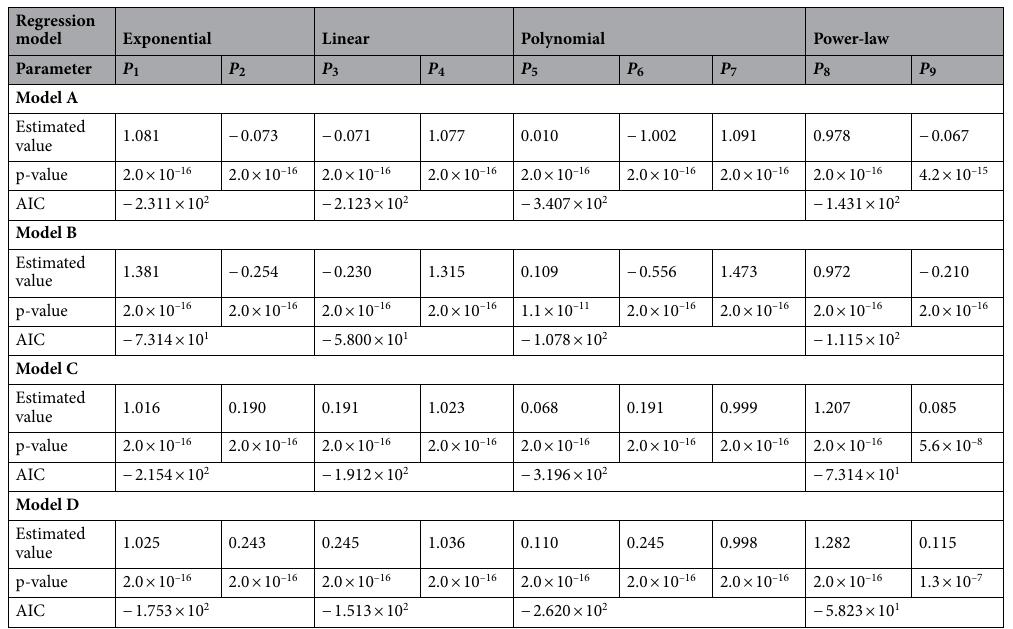
Table 2. Non-linear regression analysis